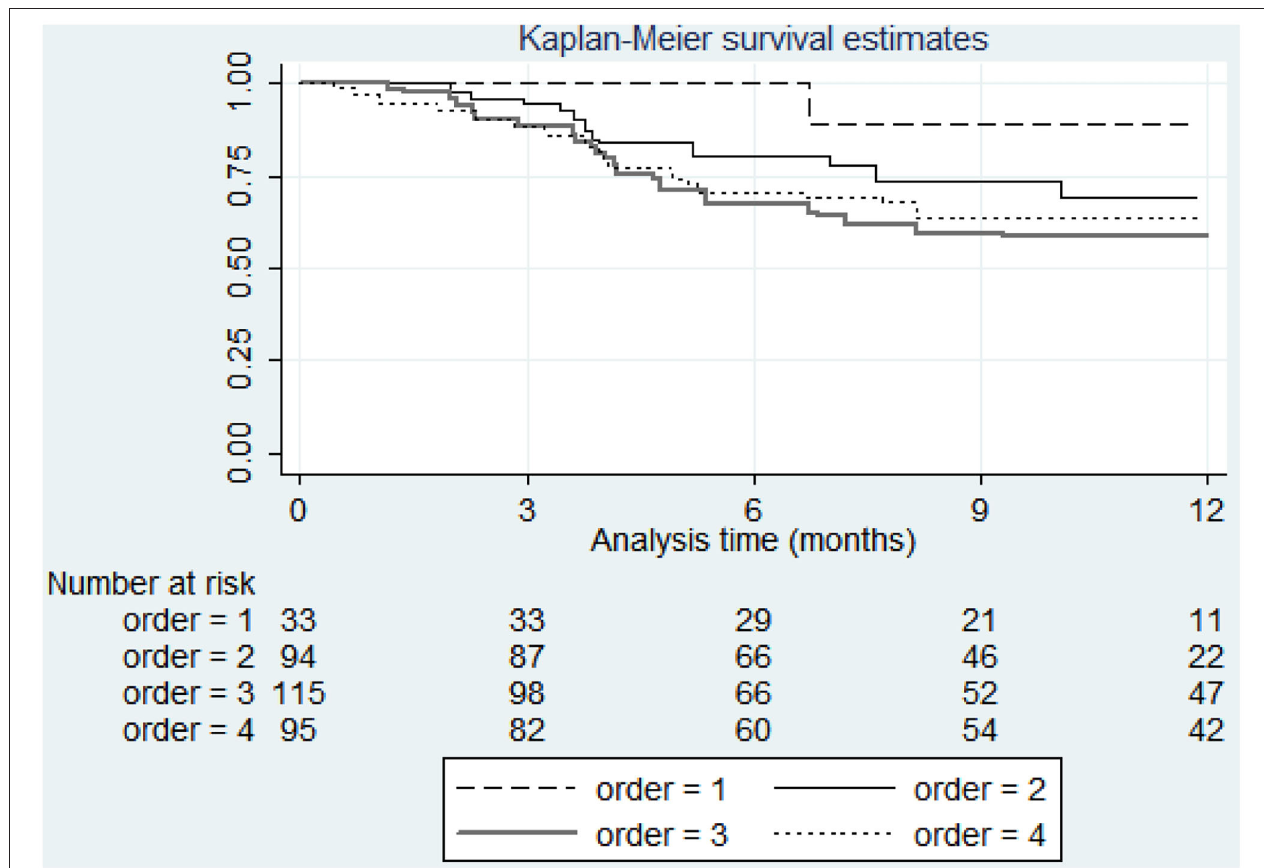
FIGURE 2 | Survival curve of secukinumab by biologic